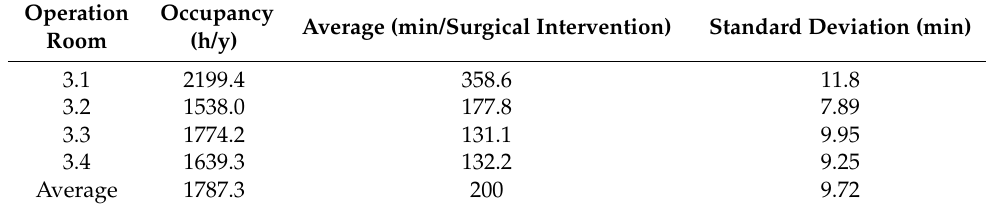
Table 2. Annual Occupancy and Average Surgical Time per OR.